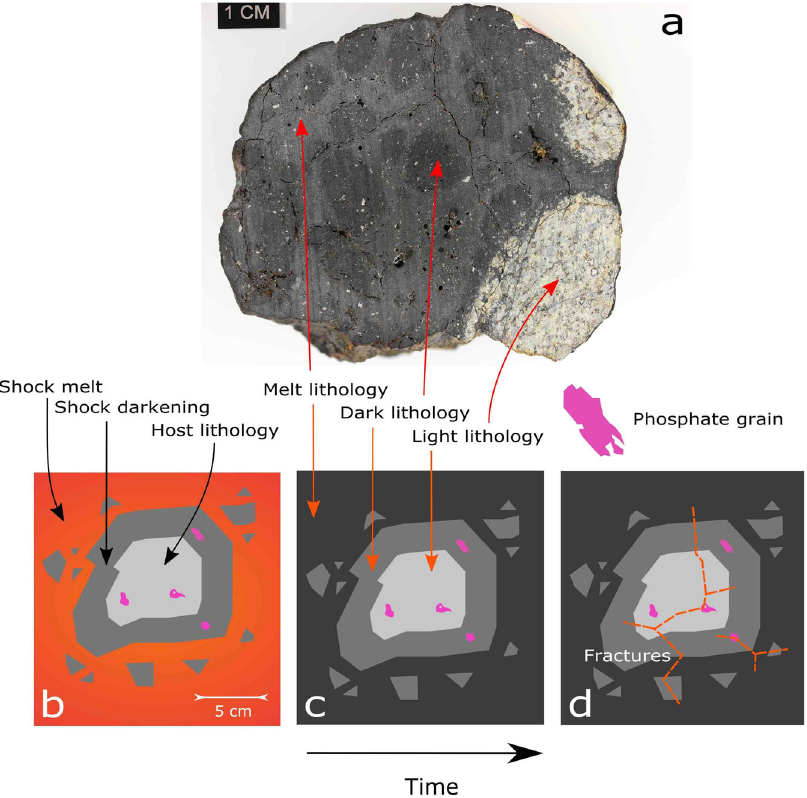
Fig. 1 Rock textures in Chelyabinsk. a – d Evolution of Chelyabinsk breccia ( a ), from ( b ) initial formation during shock-melting, brecciation, and shock darkening of host rock material, through ( c ) solidi fi cation into light, dark, and melt lithologies, and ( d ) subsequent minor disturbances, such as the propagation of fracture networks. Pink symbols represent host-rock phosphate minerals, which are only found in the light and dark lithologies. Photograph used is of Chelyabinsk specimen NHMV-O707; Credit Ludovic Ferriére-NHM Vienna,